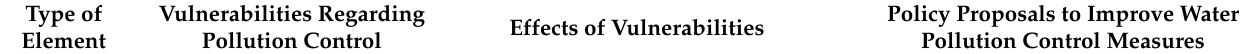
Table 4. General framework of vulnerabilities on combating heavy metal pollution in